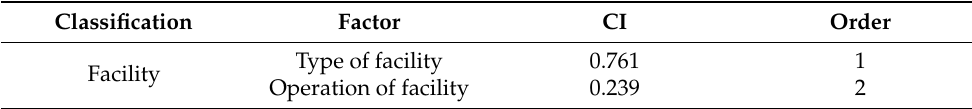
Table 5. Results of the relative importance of the facility in H3. Classification Factor CI Order Type of facility 0.761 1 Facility Operation of facility 0.239 2